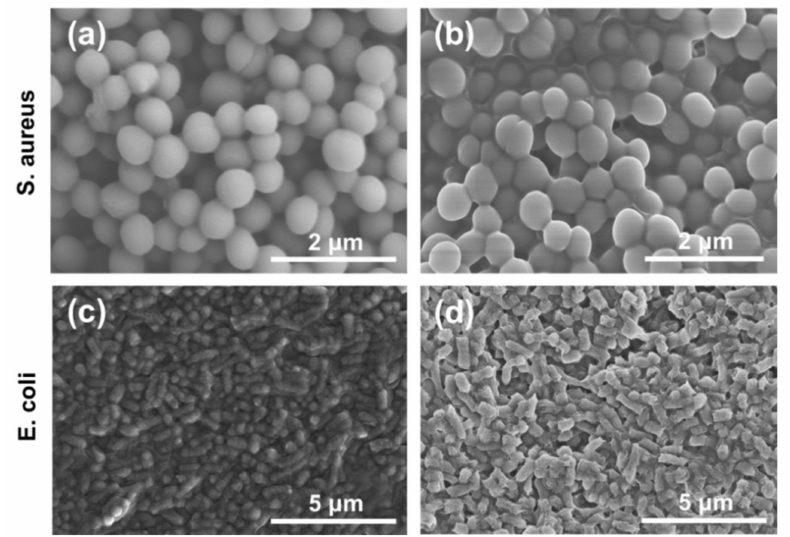
Figure 6. SEM images of S. aureus cells at 0 h ( a ) and 2.5 h ( b ), and E. coli cells at 0 h ( c ) and 2.5 h ( d ) co-cultivation with Nylon-11/F-CD nanofiber